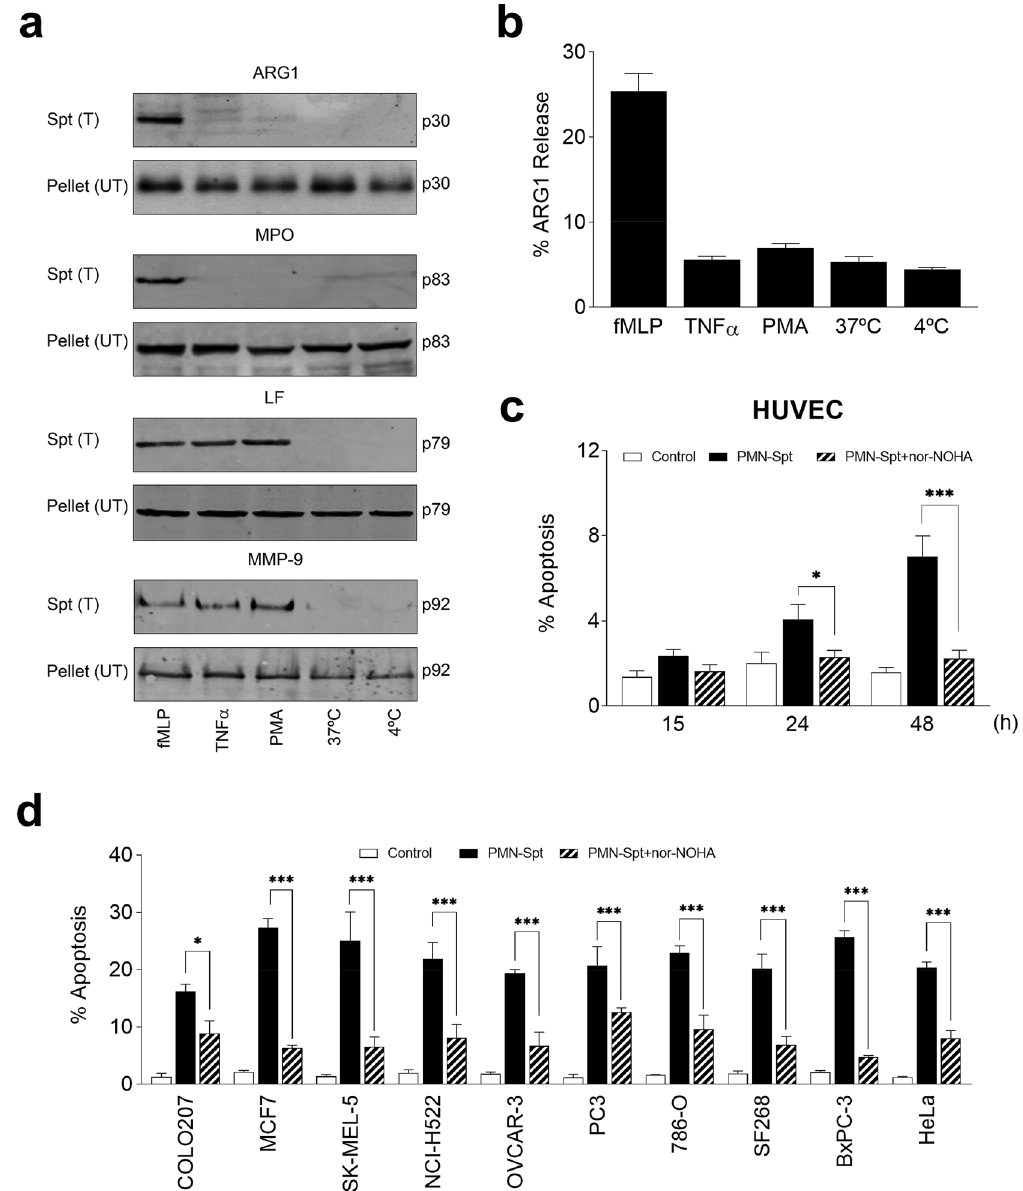
Figure 3. Arginase-1 is secreted in activated neutrophils and induces apoptosis in tumor cells lines. ( a ) 1.5 × 10 7 neutrophils were incubated for 15 min at 4 °C, and at 37 °C in the absence or presence of 100 nM fMLP, 50 ng/ ml TNFα or 2.5 μg/ml PMA. Cells were then pelleted by centrifugation and the secreted proteins were identified by Western blot in the supernatants of treated cells [Spt (T)]. In parallel, untreated neutrophils were also centrifuged, and pellets [Pellet (UT)] were analyzed for the indicated proteins to assure the presence of similar protein content before stimulation. Molecular weights (in kilodaltons) of each protein are indicated at the right side of the panel. ARG1 arginase-1, MPO myeloperoxidase, LF lactoferrin, MMP-9 metalloproteinase-9. Western blot images are representative of three independent experiments. ( b ) The percentage of arginase-1 (ARG1) released after neutrophil activation was determined by comparing the arginase activity present in the stimulated neutrophil supernatant with the sum of the arginase activity present in the cell pellet and the supernatant after each treatment. ( c , d ) 1.5 × 10 7 neutrophils were stimulated with 100 nM fMLP, and the supernatant was co-cultured with HUVEC cells for indicated times ( c ) and with cancer cell lines for 24 h ( d ), in the absence or presence of 50 μM nor-NOHA inhibitor. The percentage of apoptosis by flow cytometry was quantified by Annexin-V staining (FlowJo X 10.0.7r2—proprietary commercial software—https:// www. flowjo. com/). Tumor cells treated with supernatants from untreated neutrophils (Control) were run in parallel. The gels were cropped to show the relevant sections. The data in ( b – d ) correspond to the mean ± SD of at least three independent experiments. Asterisks indicate significant differences. * P < 0.05; *** P < 0.001. (GraphPad